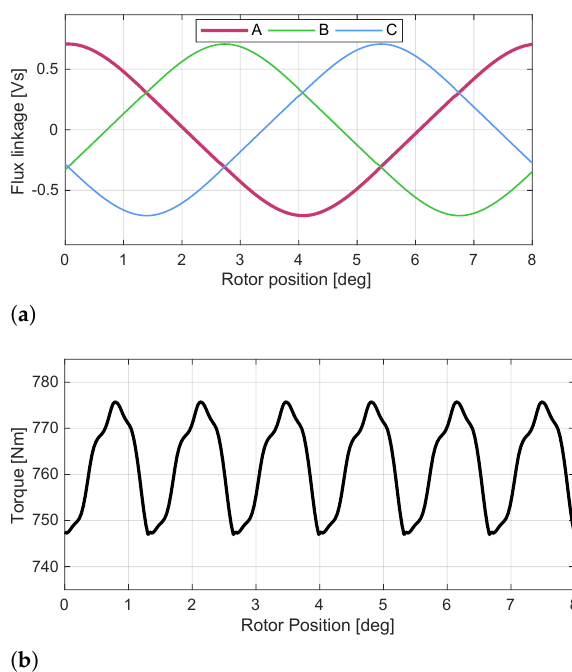
Figure 6. Analysis of the reference motor. ( a ) Flux linkage, ( b )